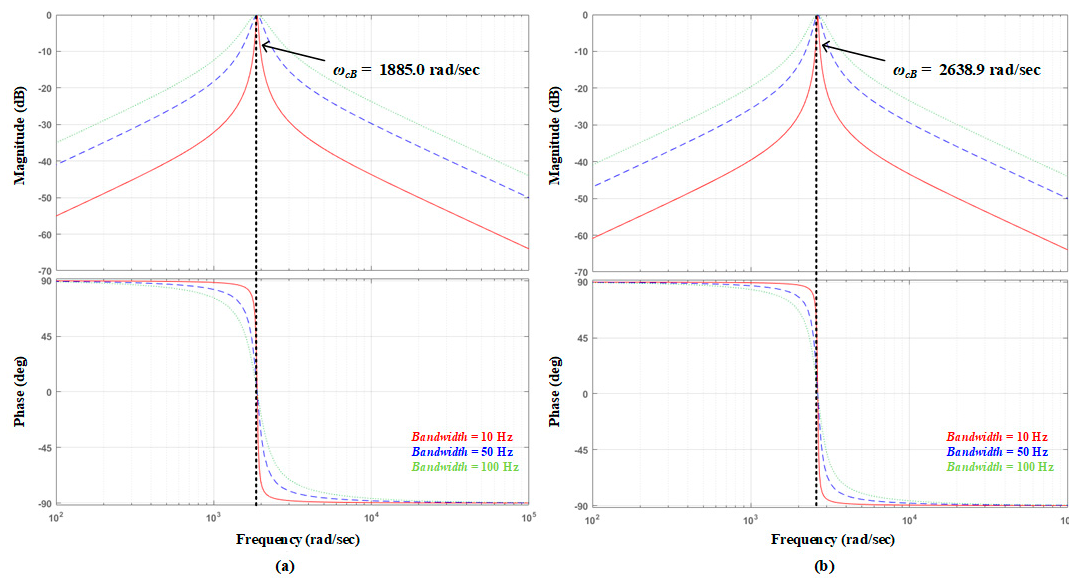
Figure 10. Bode plot of the BPF according to bandwidth in the SHE method: ( a ) center frequency ω cB = 1885.0 rad/sec, ( b ) center frequency ω cB = 2638.9 rad/sec.